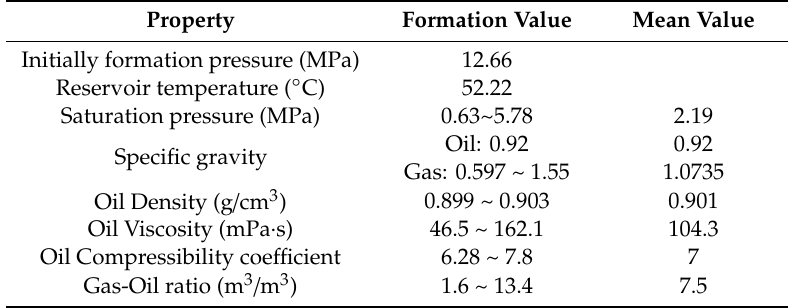
Table 2. Parameters of fluid property in Liuhua11-1 oilfield (Reprint with permission